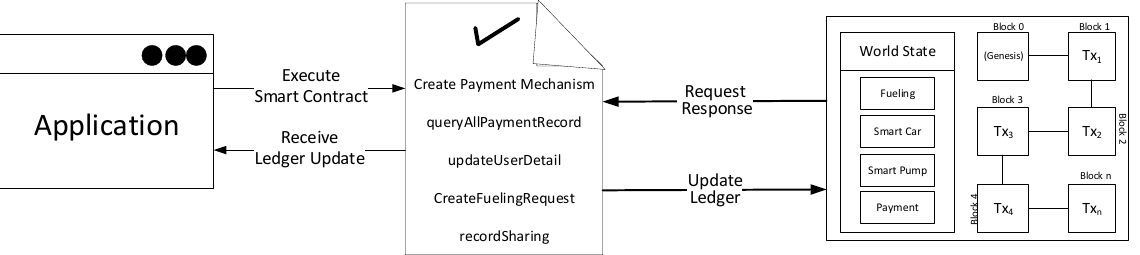
Figure 6. Ledger modification using a smart